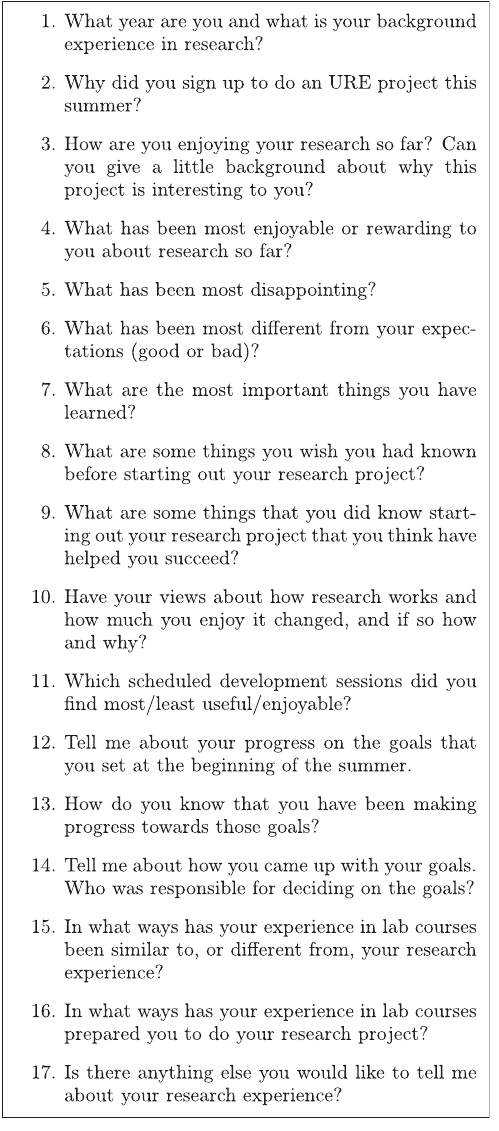
FIG. 2. List of questions used in each interview, though the order of questions